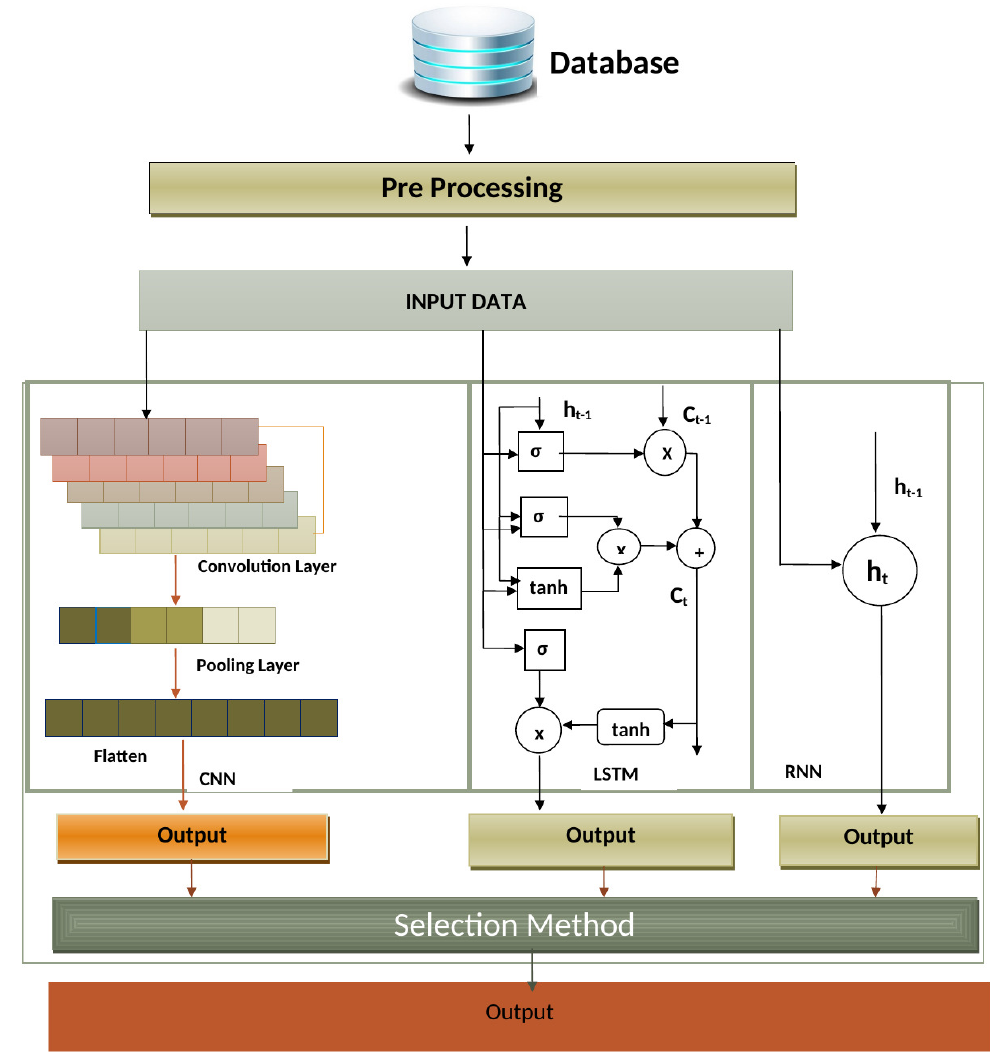
Figure 1. Architecture